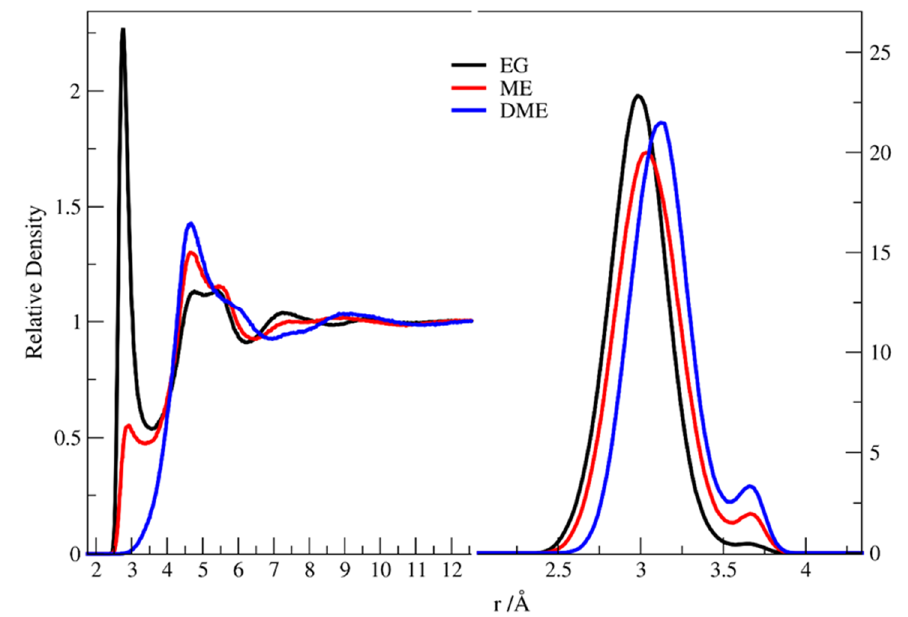
Figure 3. O1–O2 radial distribution function. Intermolecular: left panel; intramolecular: right panel. EG: black, ME: red; DME: blue.